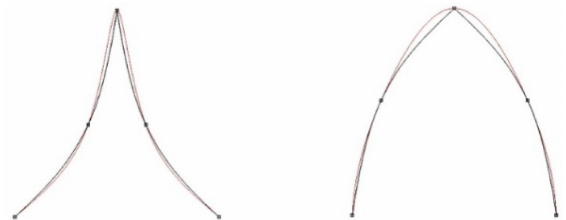
Figure 10. Undulations of the spline in the vicinity of kink point of curves making concave and convex